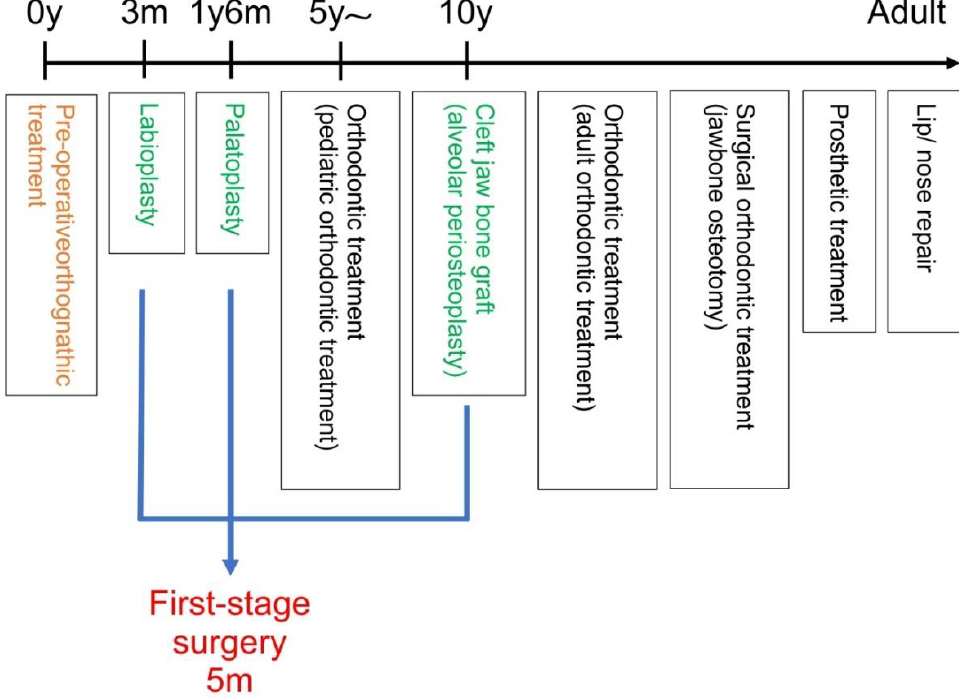
Figure 1. Flowchart of the treatment process with single-stage surgery.